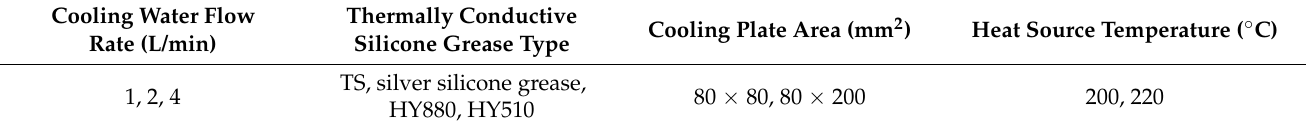
Table 2. Experimental conditions for temperature difference power module performance